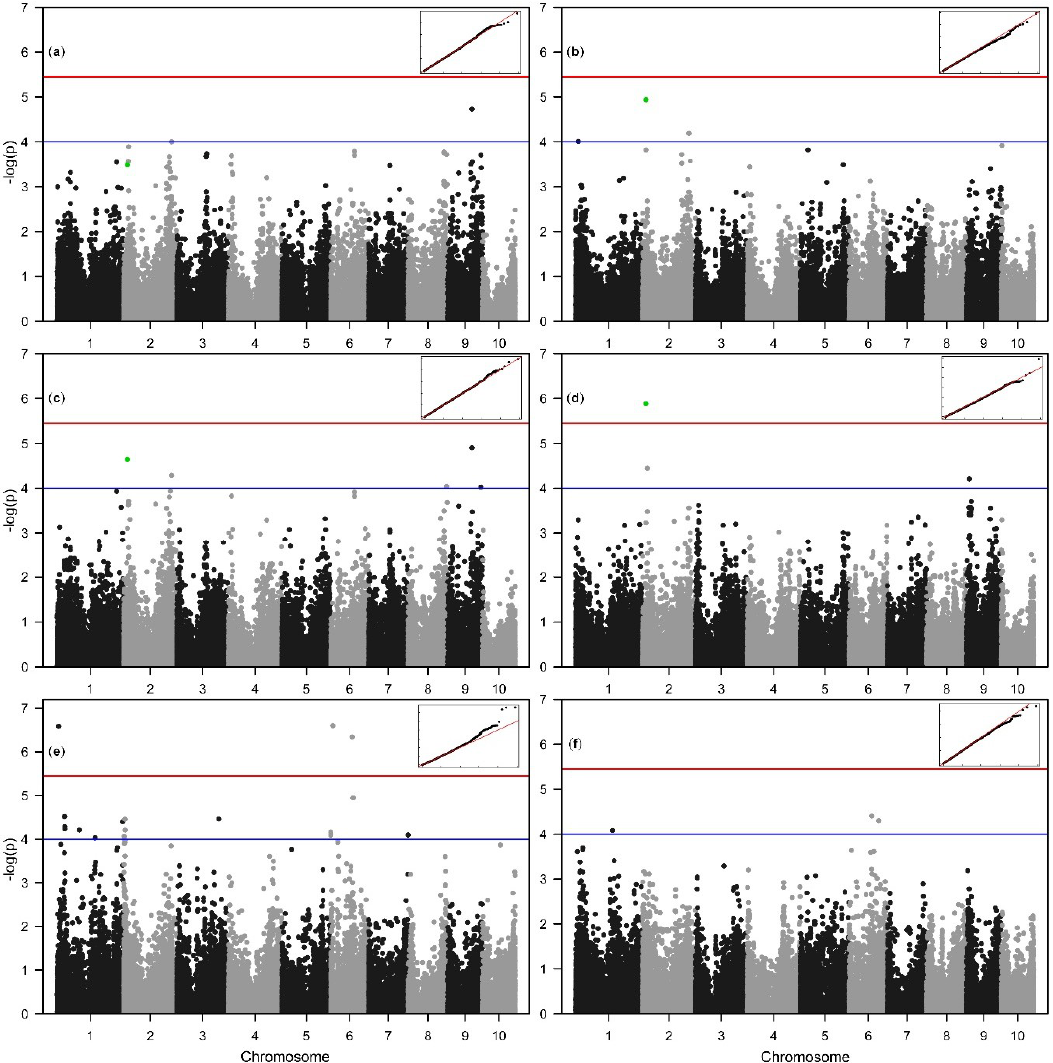
Figure 3. The Manhattan and the respective quantile-quantile (Q-Q) plots of the –log(P) values of the associations from MLM+Q+K+HKW analysis for fresh weight in control ( a ), fresh weight in water withholding treatment ( b ), dry weight in control ( c ), dry weight in water withholding treatment ( d ) and MLM+Q+K for dry matter content in control ( e ) and dry matter content in water withholding treatment ( f ). Blue line represents arbitrary threshold value of 4, while the red line represents the Bonferroni corrected threshold value of 5.45. Marked in green in plots (a – d) is the SNP S10_139734834 on chromosome 2, associated with Calmodulin binding protein. Table 3. SNPs crossing arbitrary threshold of 4 associated with biomass traits fresh weight in grams (FW), dry weight in milligrams (DW), and dry matter content as % of FW (DMC) in control (C) and water withholding (WW) treatments. In bold are the SNPs crossing Bonferroni corrected threshold value for significance at α = 0.05. Shown are the results for MLM + Q + K + HKW analysis for DW and FW and MLM + Q + K for DMC. Results of MLM + Q + K without HKW for FW and DW are available as Supplementary Table S2.